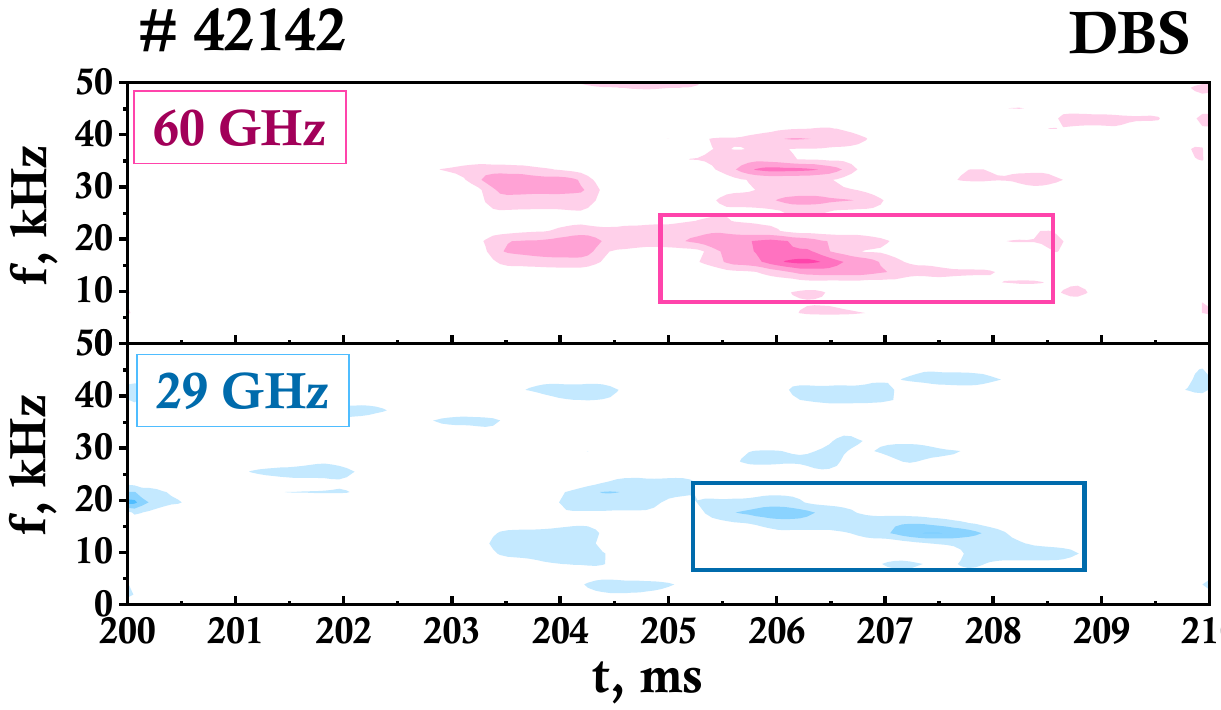
Figure 9. Spectrograms of the DBS phase derivative for discharge #42142.